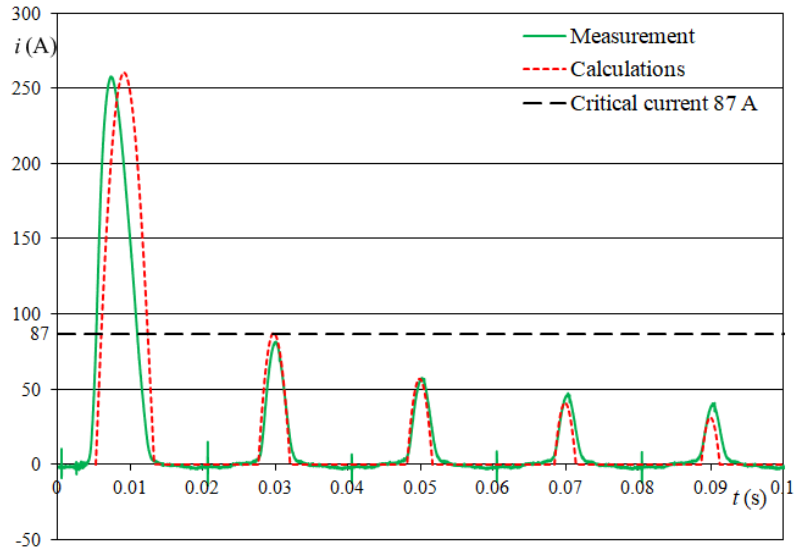
Figure 17. Five consecutive 13.8 kVA HTS transformer inrush current pulses, measured and cal- culated.